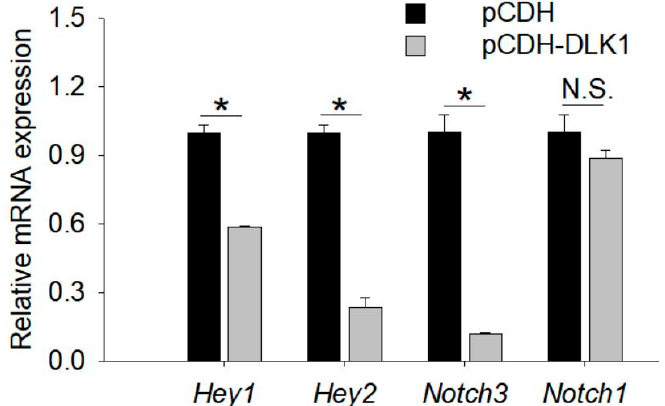
Figure 6. DLK1 negatively regulated Notch signaling pathways. The mRNA expression of Notch- related genes in the control and DLK1- overexpressed myoblasts. The data represent the mean ± SD of three independent experiments. * p < 0.05, N.S., not significant.